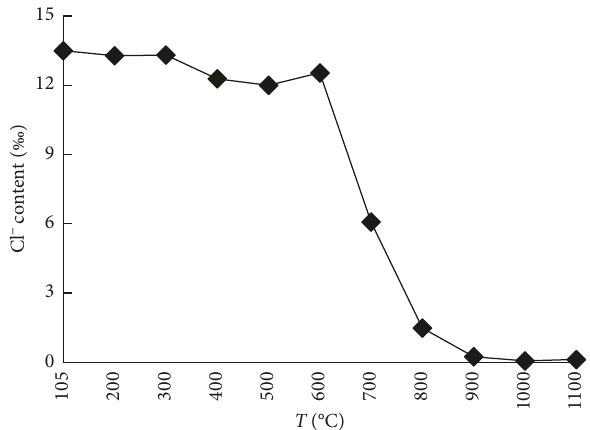
Figure 5: Changes of chlorine content with different sintering